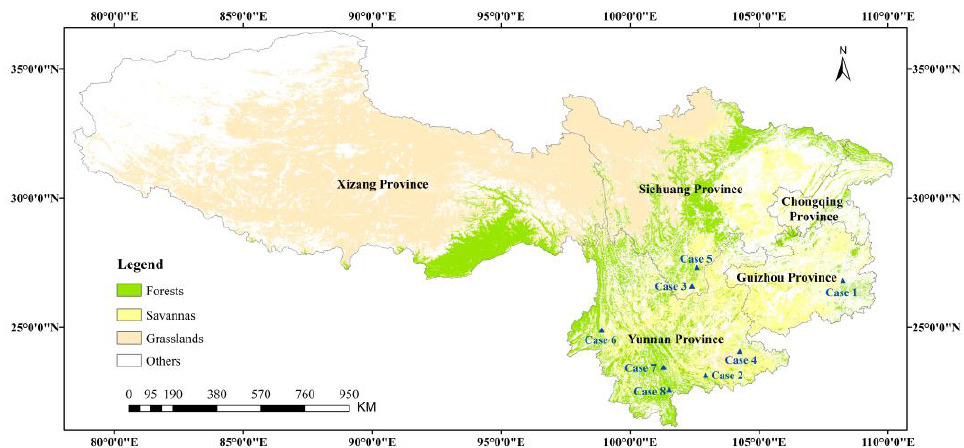
Figure 1. Overview of the study area and the forest and grassland distribution. The eight captured plumes (blue triangles) by CALIOP and corresponding fire case numbers are labelled.